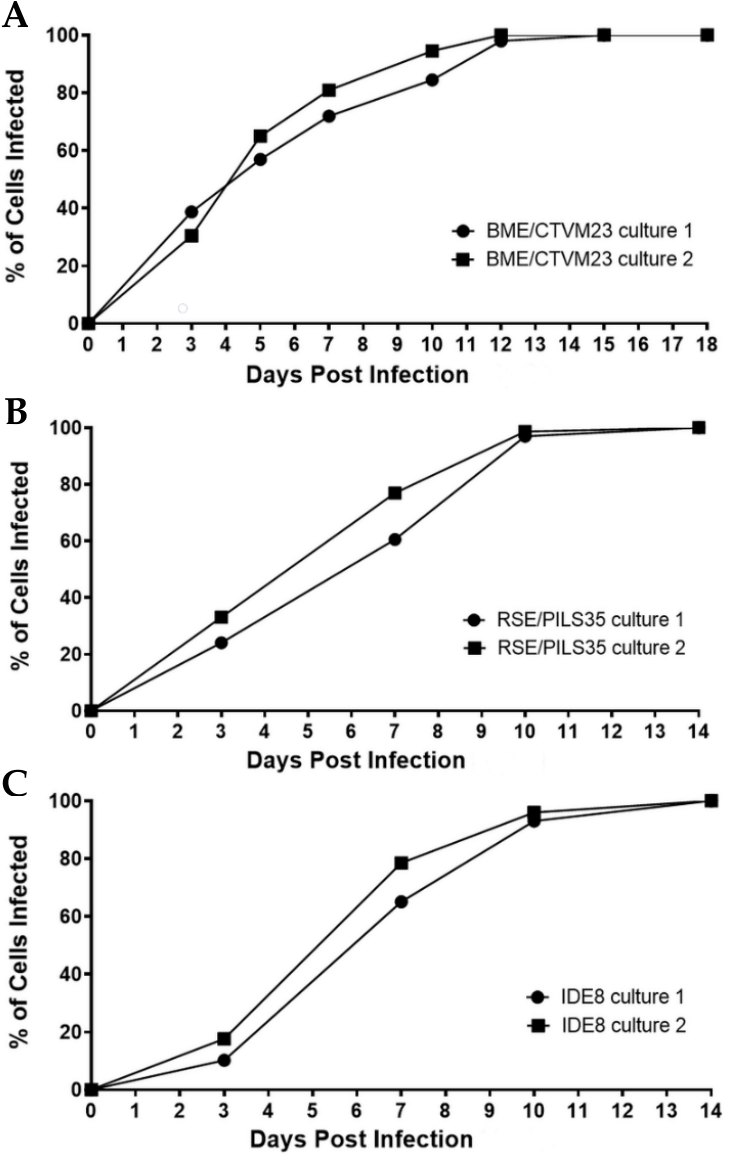
Figure 2. Rickettsia raoultii infection rate curves in two replicate cultures in each of the tick cell lines BME/CTVM23, RSE/PILS35 and IDE8. ( A ): R. raoultii -infected BME/CTVM23 cultures, ( B ): R. raoultii -infected RSE/PILS35 cultures, ( C ): R. raoultii -infected IDE8 cultures. The infection rates were calculated based on the percentage of infected cells observed among 200–300 cells counted in Giemsa-stained cytocentrifuge smears prepared at the indicated days post infection.